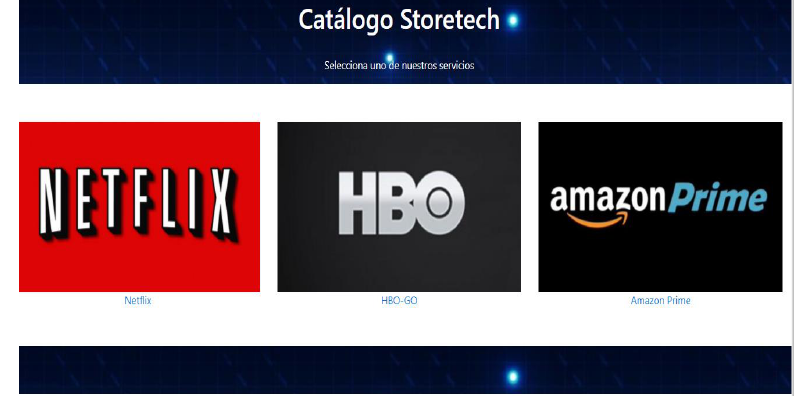
Figure A1. Experimental stimulus: Services brands.